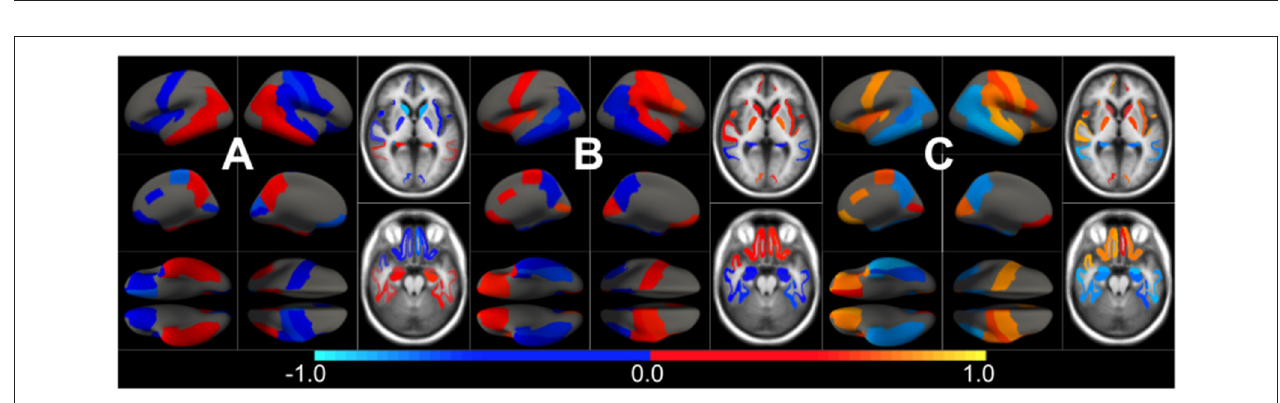
FIGURE 3 | Different views of the effect of AD ( ν AD k ) in subjects along the AD continuum. The color-code represents negative (blue) and positive (red) relative contributions of each CSF biomarker explaining the volumetric variability on brain each ROIs. Each figure represents a different CSF biomarkers: (A) CSF A β , (B) CSF p -tau, (C) CSF t -tau. Only brain ROIs with statistically significant effect size ( p < 0.05, corrected for multiple comparisons) are